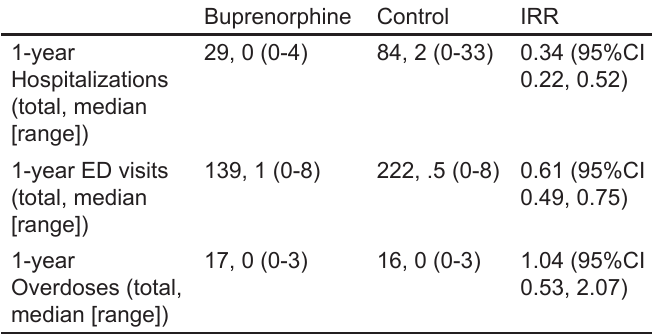
Table 2. Average healthcare utilization for experimental and control